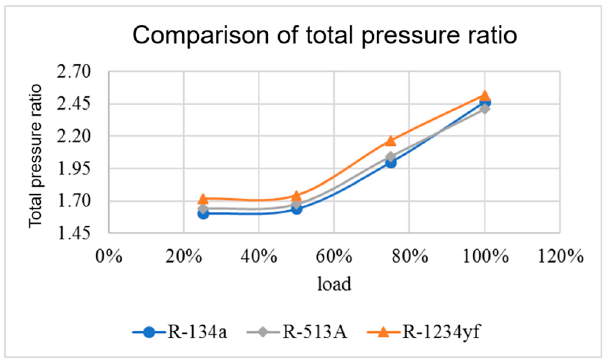
Figure 11. Comparison diagram of total pressure ratio of refrigerants .